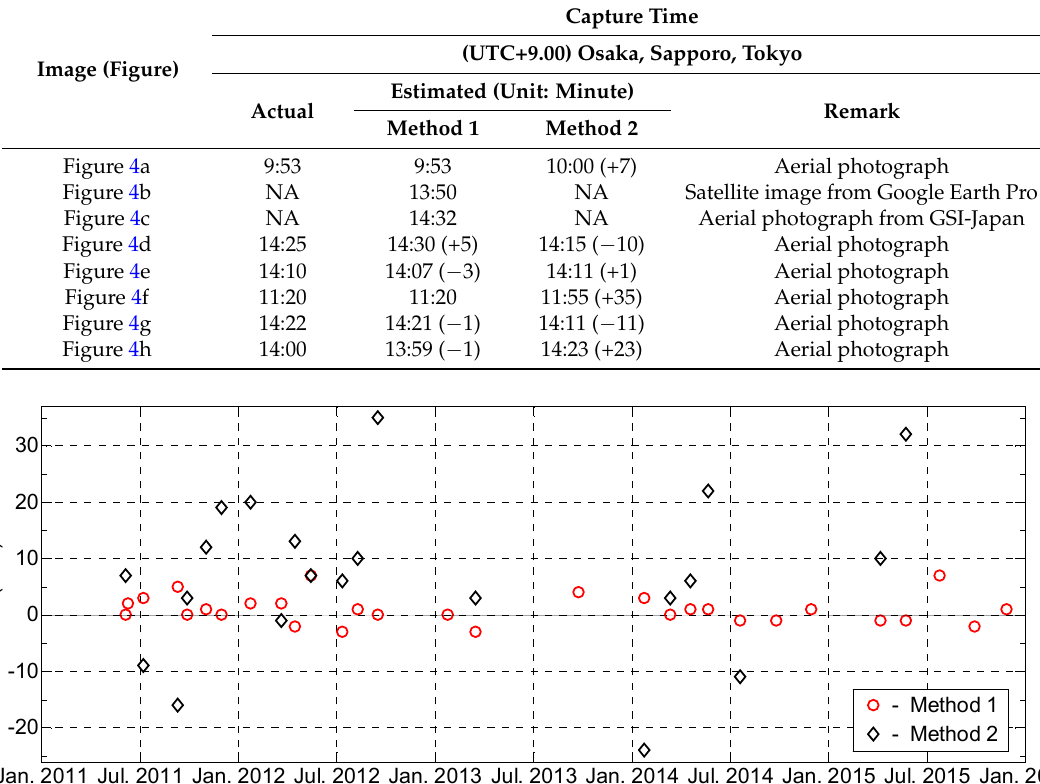
Figure 5. Error of estimated capture time of aerial photograph ( ∆ t = estimated capture time—actual capture time).